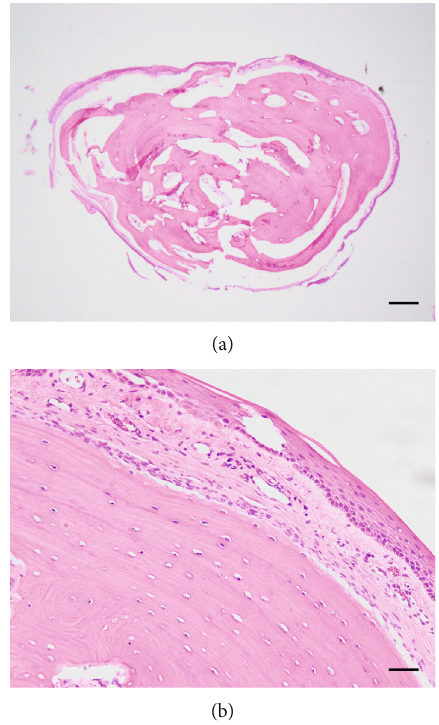
Figure 2: Histological fi ndings. (a) Low-power image. A nodule consisting of matured bone surrounded by normal fi brous tissue was observed. Squamous epithelium that covered them is